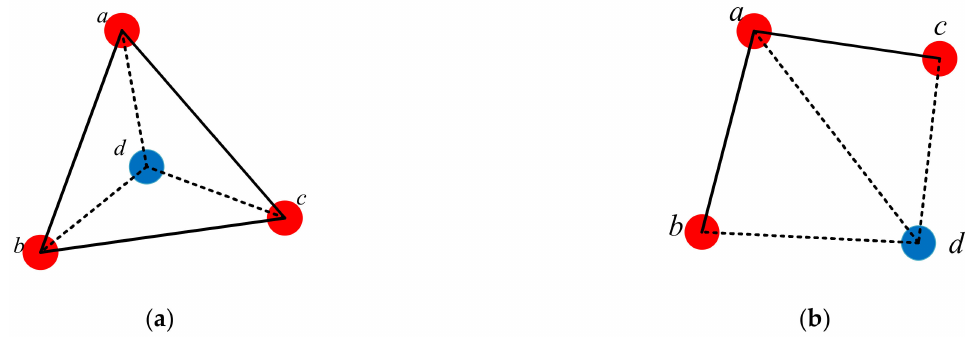
Figure 4. Triangulation diagram. ( a ) Inside the triangle. ( b ) Outside the